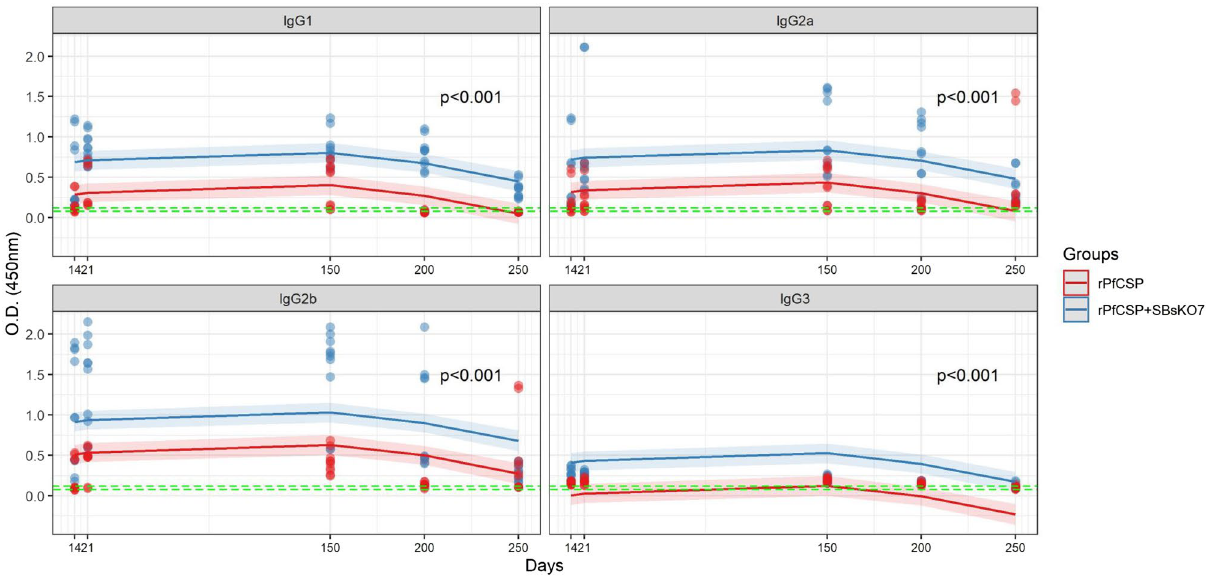
Figure 3. Indirect ELISA quantification of IgG subclasses in groups immunized only with r Pf CSP and with r Pf CSP + S Bs KO7. The green horizontal lines correspond to the negative control variation (S Bs KO7 1 × 108 and PBS). Each graph represents the quantification of the IgG1, IgG2a, IgG2b, and IgG3 subclasses of the r Pf CSP (red line) r Pf CSP + S Bs KO7 (blue line) mice groups. Each point corresponds to the mean O.D. (450 nm) of each value was significant over